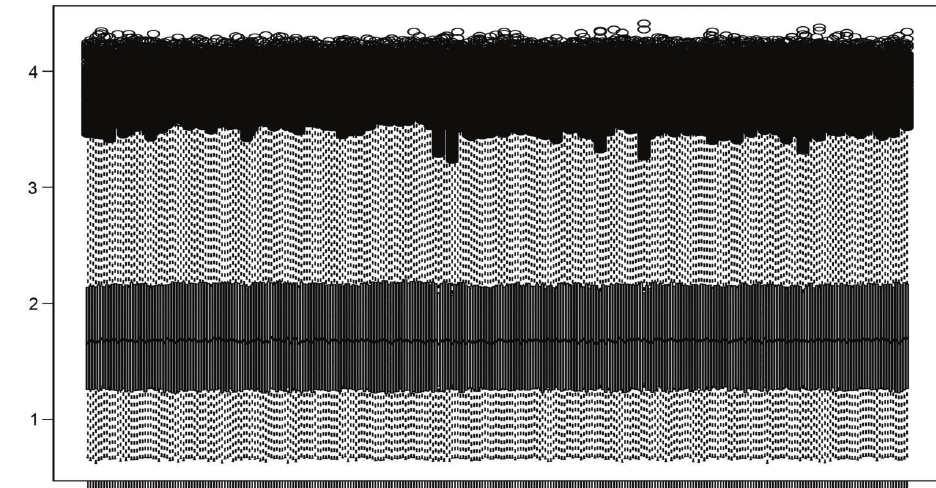
Figure 6. Box plot distribution of GSE62254 dataset.